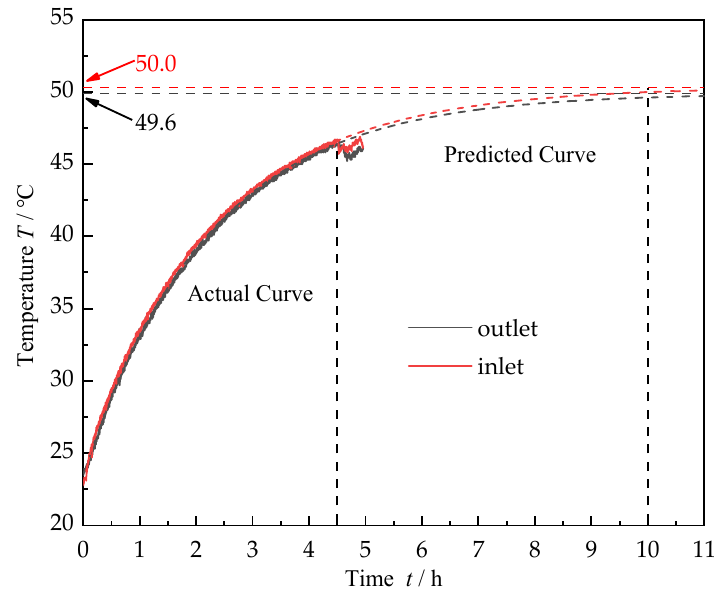
machine ran for 10 h. The thermal balance temperature was about 50 ◦ C. The temperature difference of the inlet and outlet was 0.4 ◦ C.